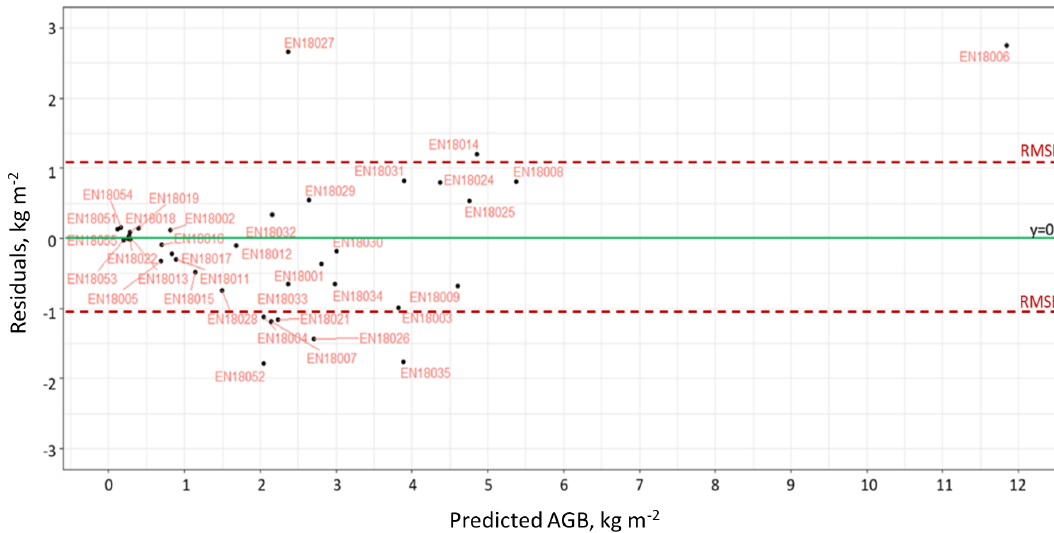
Figure 7. The distribution of residuals of the generalised additive model (GAM) trained for AGB biomass prediction.